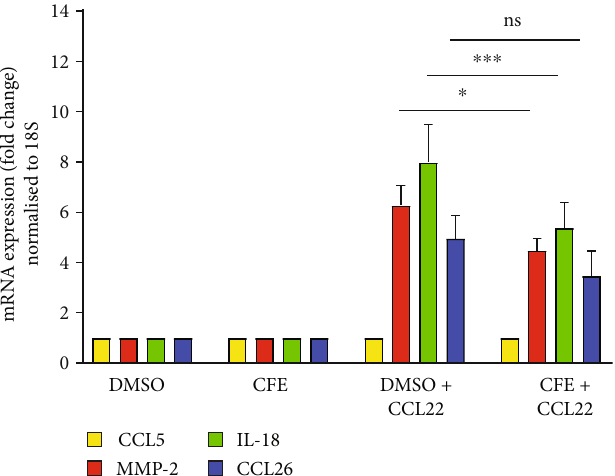
Figure 7: E ff ect of the pure corn fl ower extract (CFE, 1 mg/mL) on MMP-2, IL-8, and CCL26 expression after in fl ammation induction with CCL22. Relative gene expression was calculated using the delta-delta CT method after normalization to ribosomal 18S expression. Experiment was performed in triplicate. One-way ANOVA: ns: nonsigni fi cant; ∗ p < 0 : 05 ; ∗∗∗ p < 0 : 005